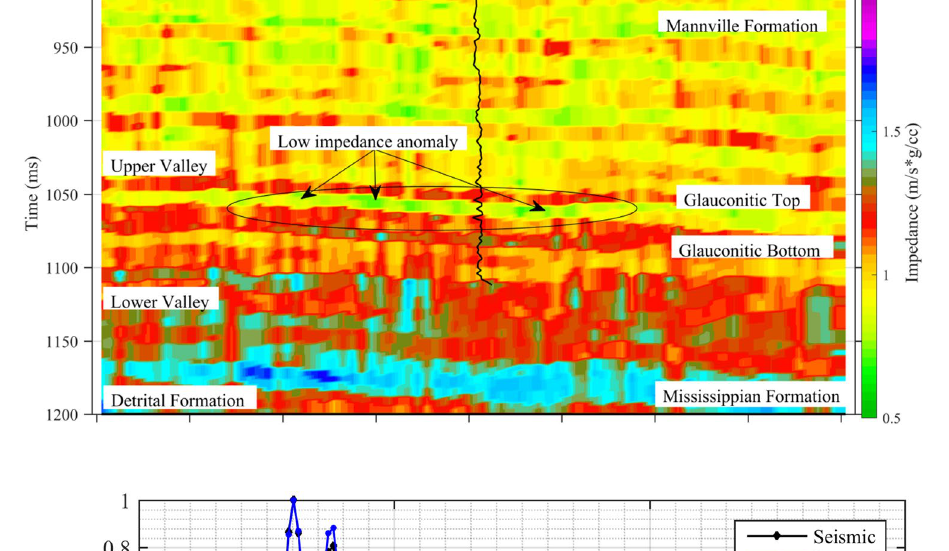
Fig. 8 Comparison of amplitude spectrum from the Blackfoot seismic and inverted synthetic